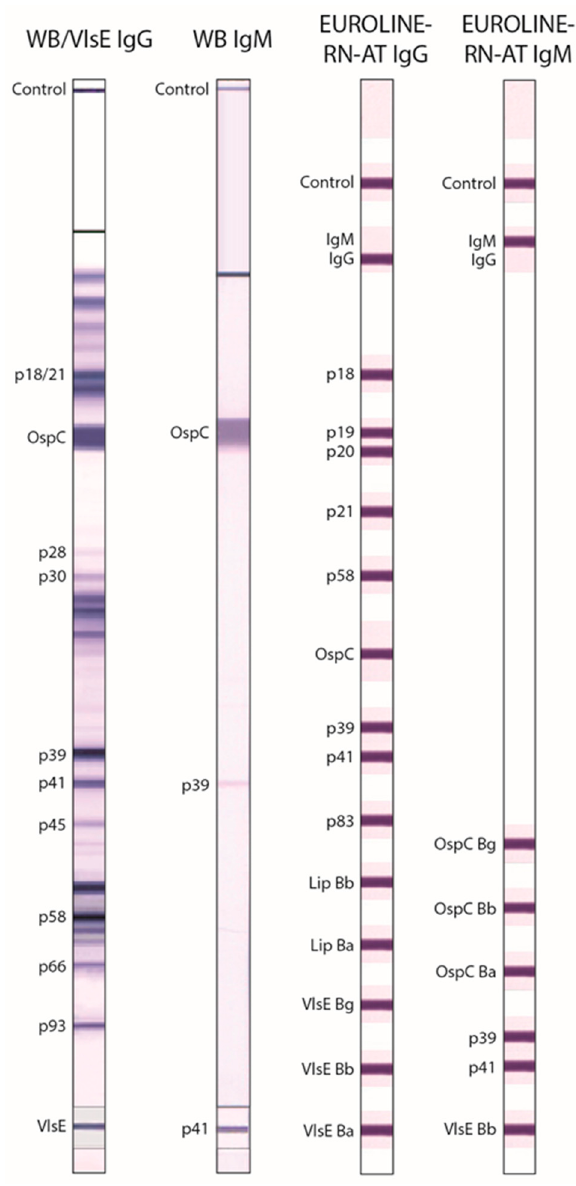
Figure 1. Anti- Borrelia immunoblot tests. Representative reactivity of the WB/VlsE IgG and WB IgM after incubation with sera from patients with late Lyme disease (IgG) and erythema migrans (IgM), respectively (left two panels). Schematic representation of antigens used in the line blot assays EUROLINE-RN-AT IgG and EUROLINE-RN-AT IgM (right two panels).